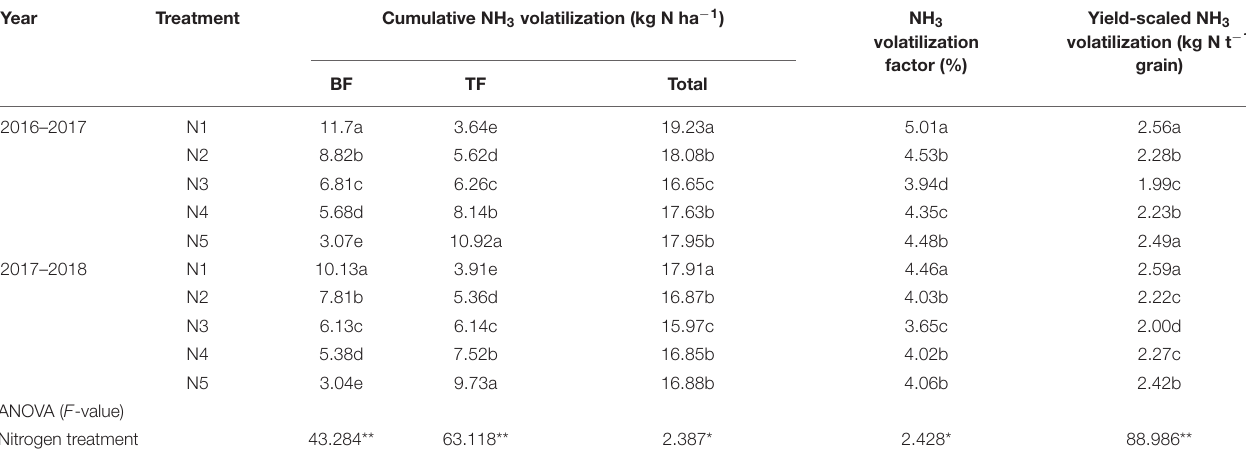
TABLE 2 | Effect of split nitrogen fertilizer on cumulative NH 3 volatilization, NH 3 volatilization factor, and yield-scaled NH 3 volatilization.